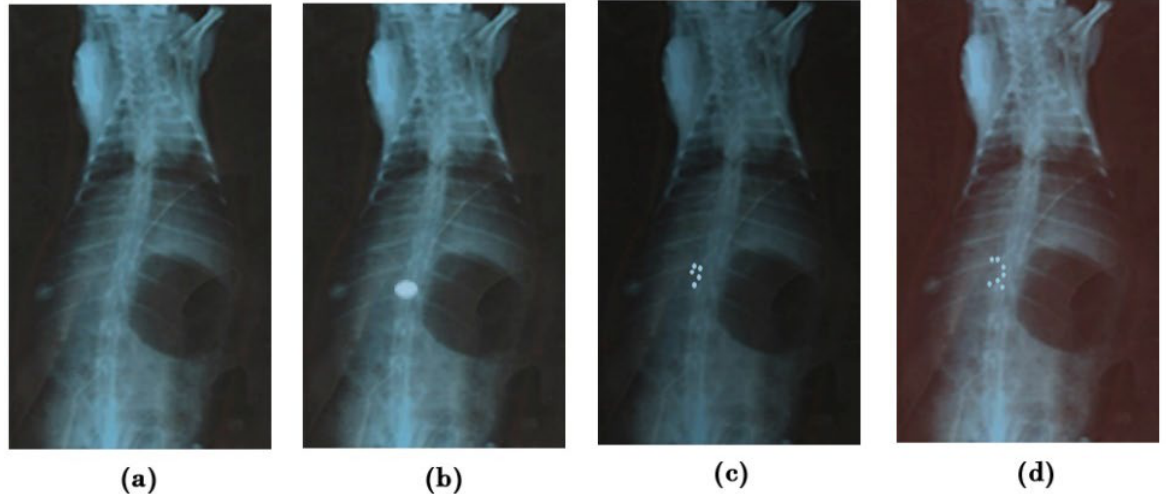
Figure 8. X-ray radiograms ( a ) before administering ( b – d ), showing mucoadhesion of G-STO-M at 1, 4, and 8 h, correspondingly.